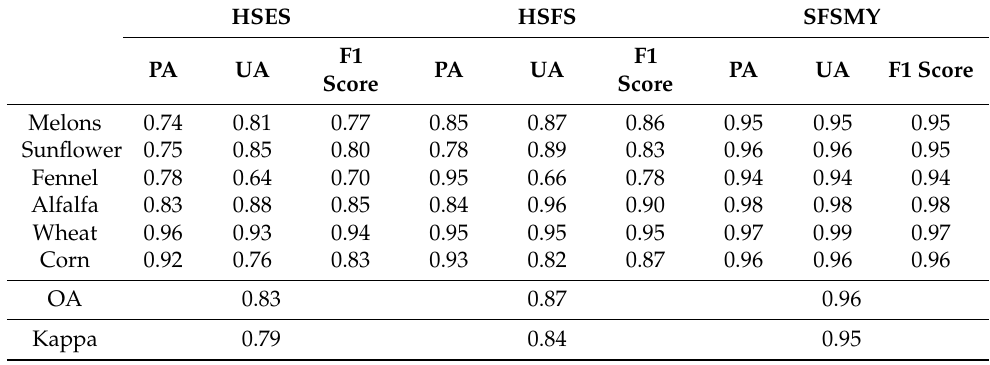
Table 4. Accuracy of crop classification in the Shiyang River Basin using different mapping methods.